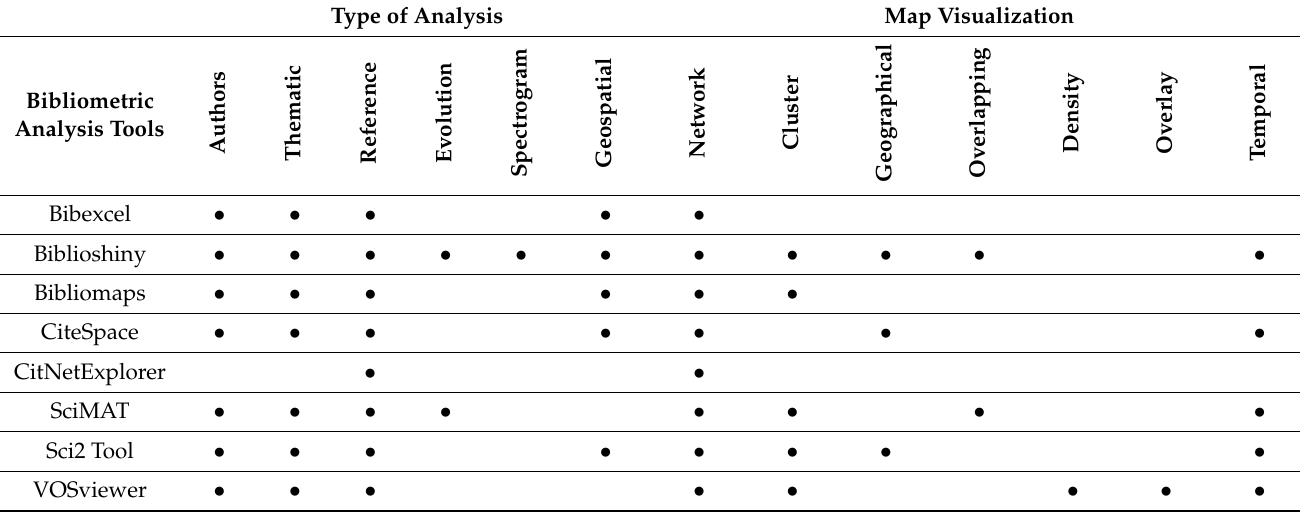
Table 1. Bibliometric analysis tools features comparison based on [23]. Type of Analysis Map